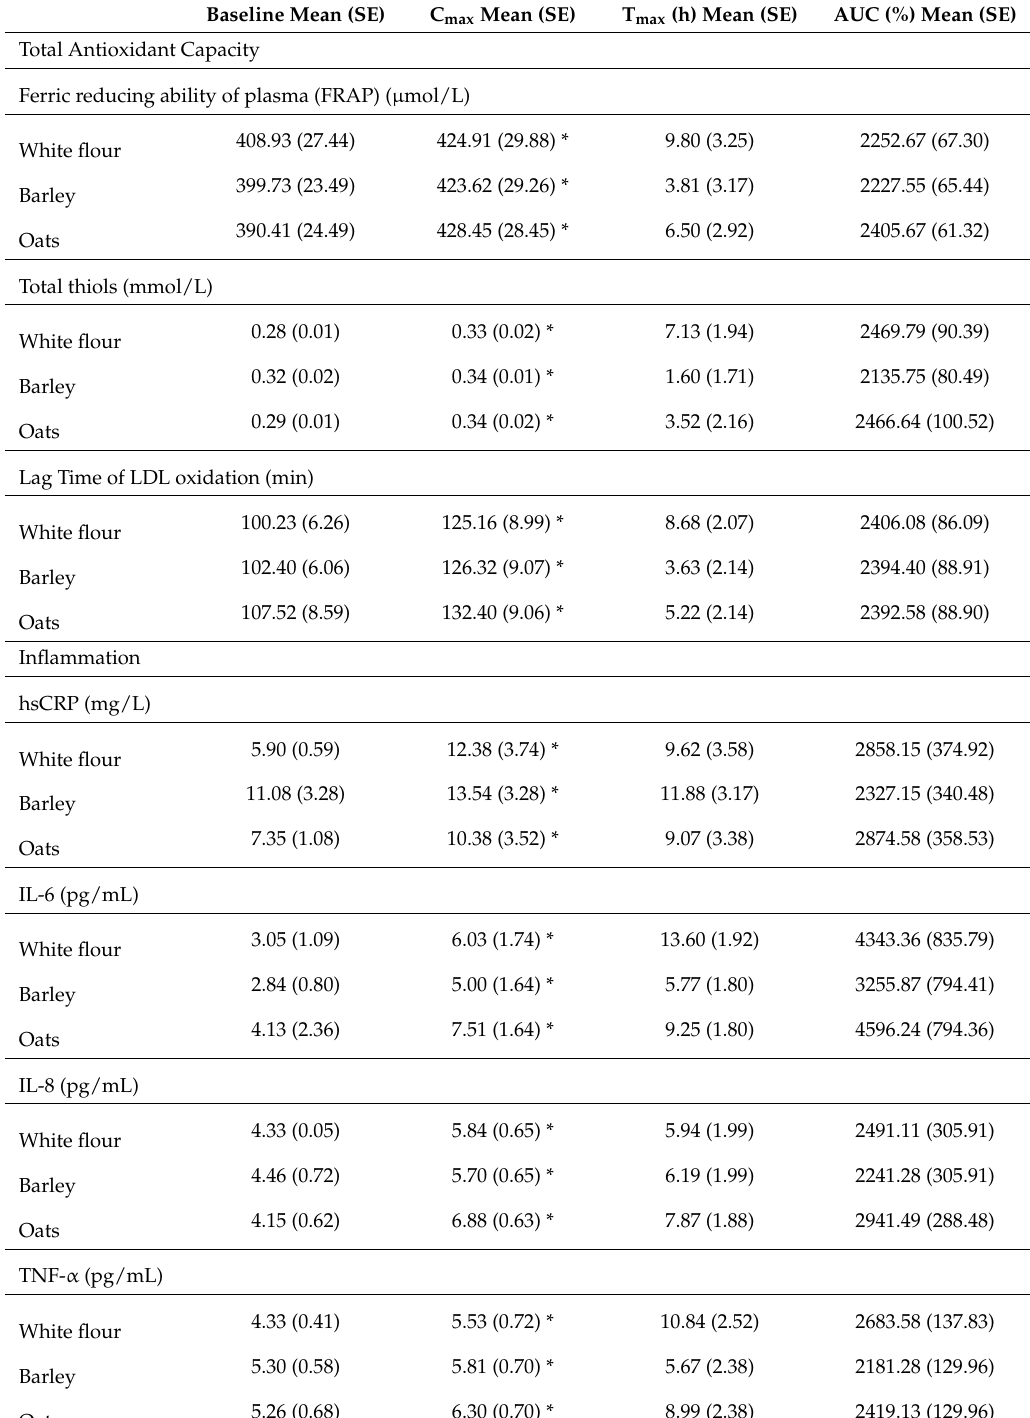
Table 4. Postprandial response of biomarkers associated with cardiovascular disease (CVD) and/or type 2 diabetes mellitus (T2DM) risk in humans consuming muffins made with whole oat, whole barley or refined wheat flour (0–24